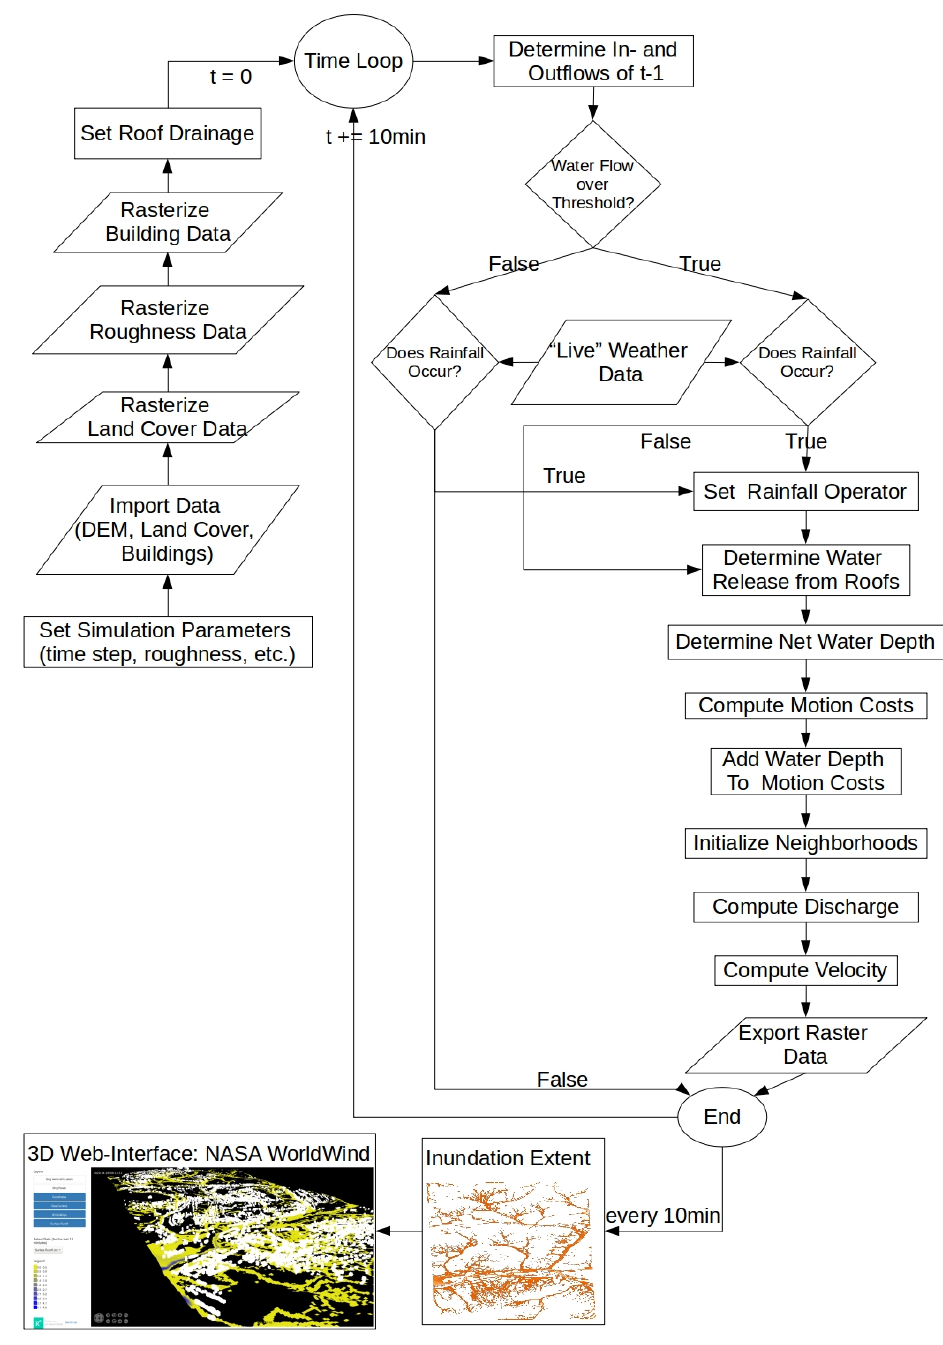
Figure 3. The algorithm of CAMC in “live” simulation